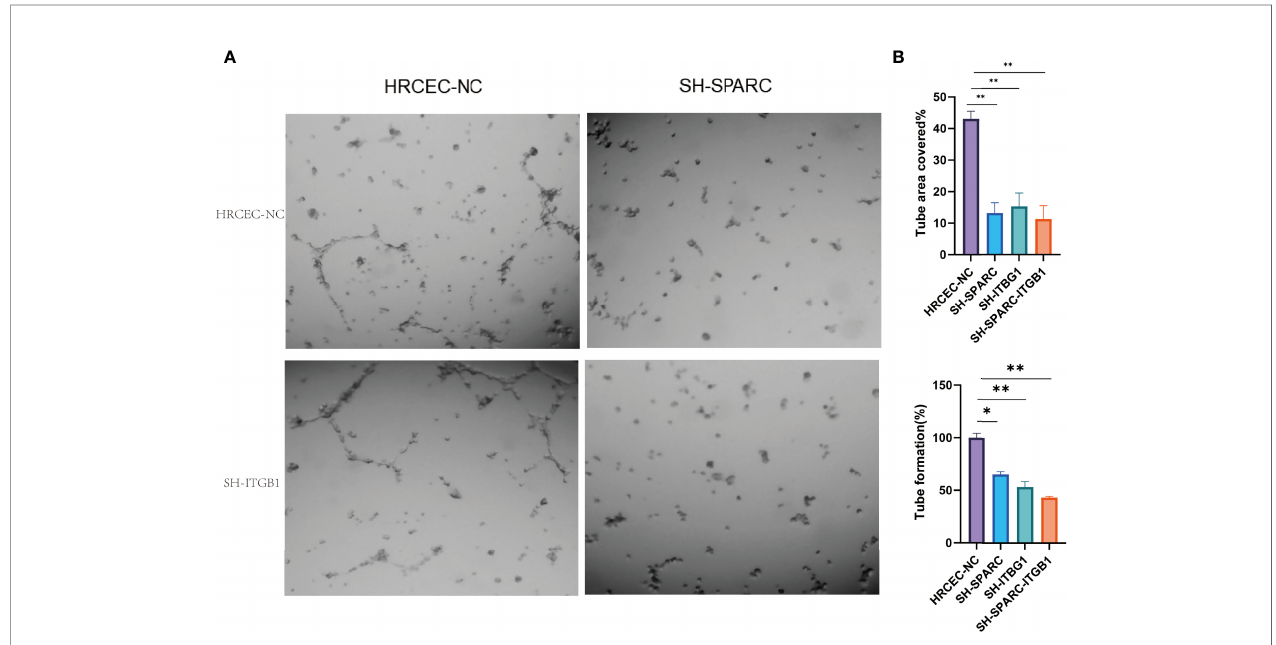
FIGURE 9 | The tube formation of ablation of SPARC and ITGB1 experiments. (A) Representative fi gure of tube formation. (B) Tube formation area covered. (C) Tube formation rate. *: p < 0.05,**: p <